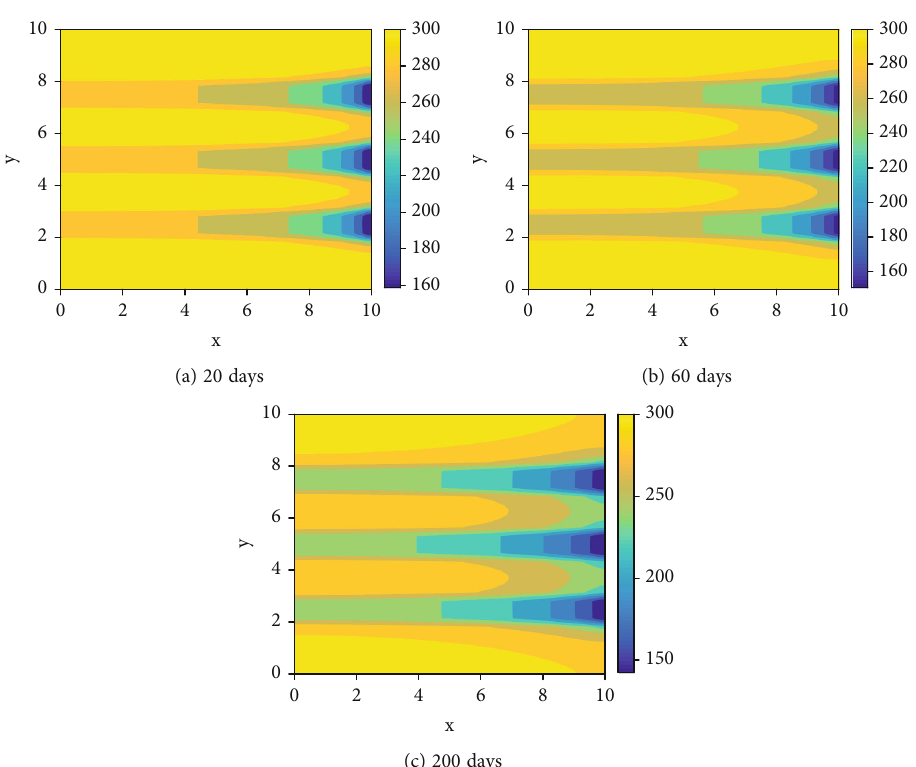
= 40 mol/m 3 at di ff erent times. b